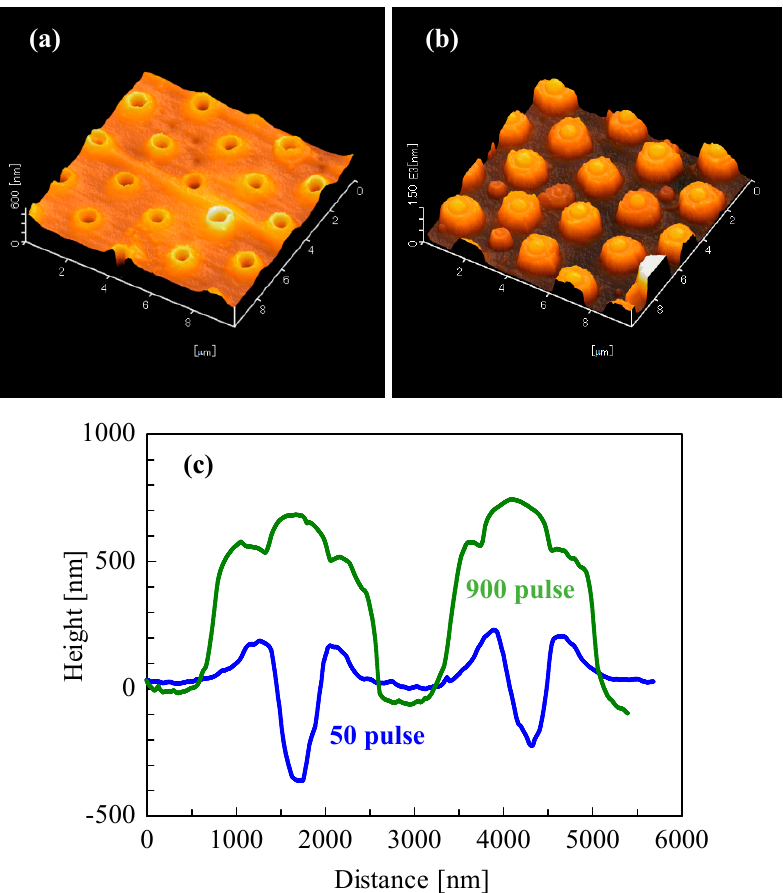
Figure 6. AFM images of the photochemical micro-/nano-swelling formed on silicone rubber at laser pulse numbers of ( a ) 50 and ( b ) 900, and ( c ) these profiles. The pulse-repetition rate was 2 Hz.